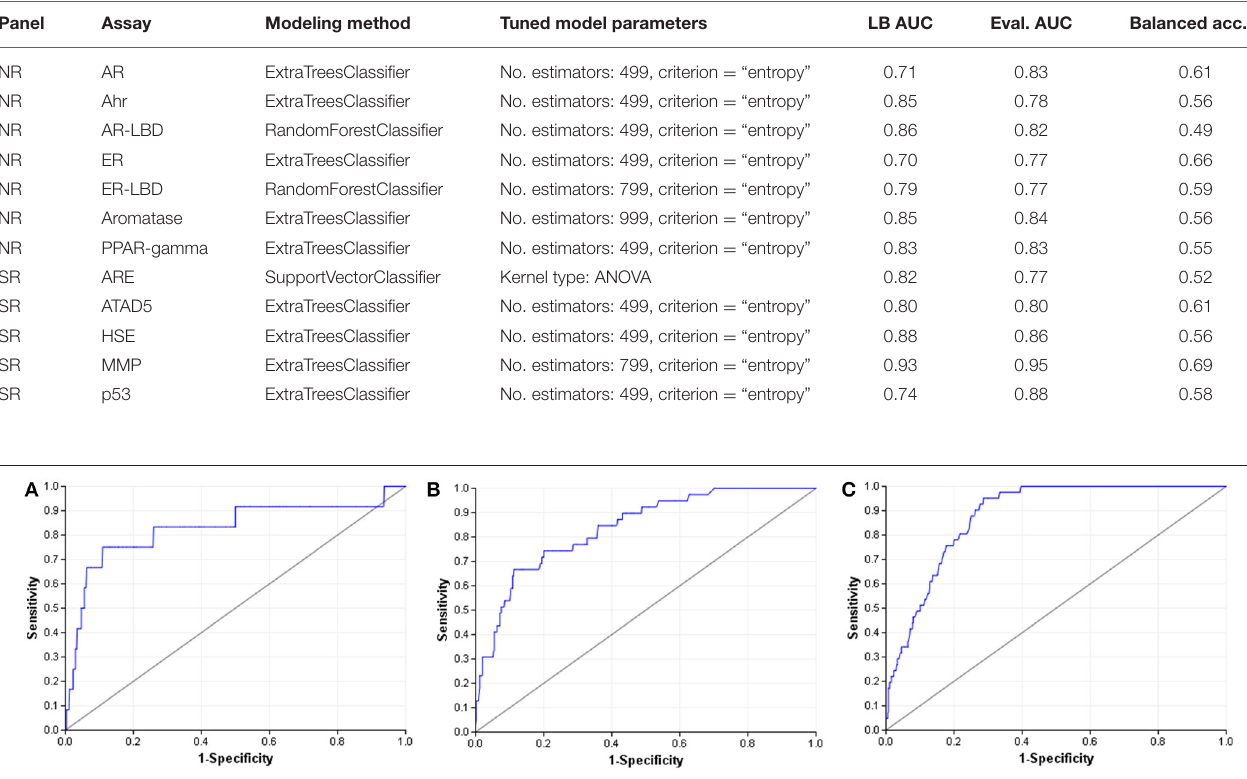
increased performance. In this case, multiple tree models are used to creating a forest as introduced by Breiman